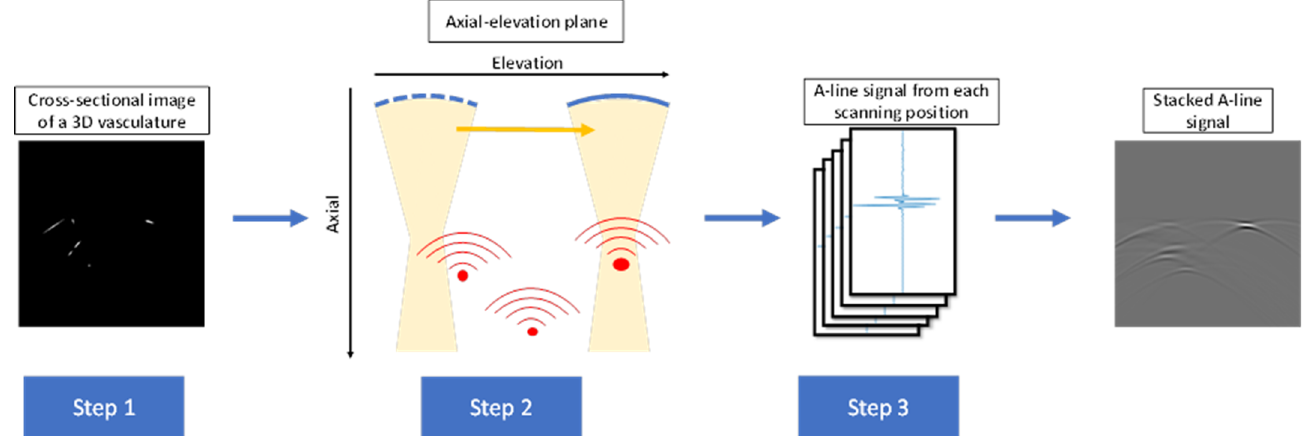
Figure 1. Workflow of PA simulation. Step 1: Resized PA source matrices were placed 30 mm away from the transducer element. Step 2: The transducer moved along the elevation direction to acquire acoustic signals. Step 3: Received signals at different transducer locations were stacked into one image.